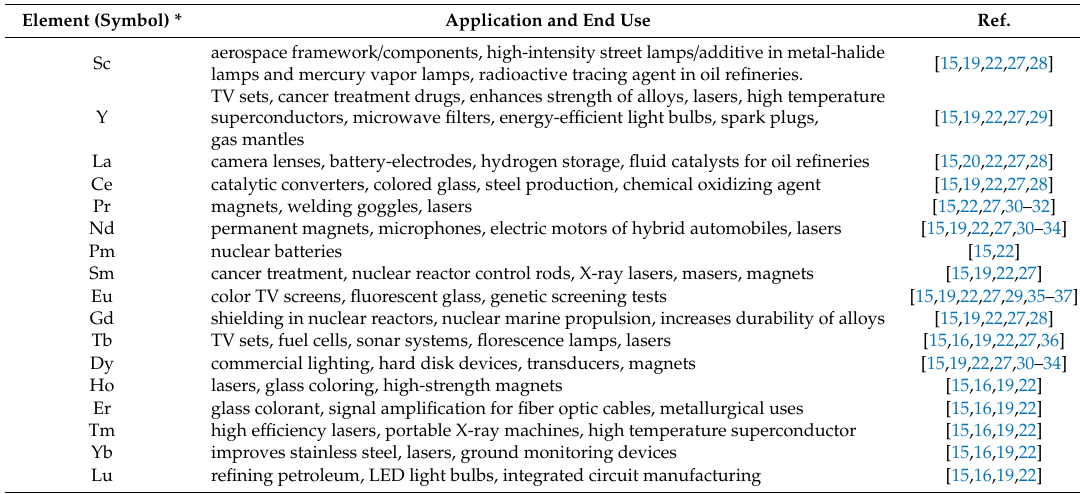
Table 1. Overview of REEs applications and end uses.